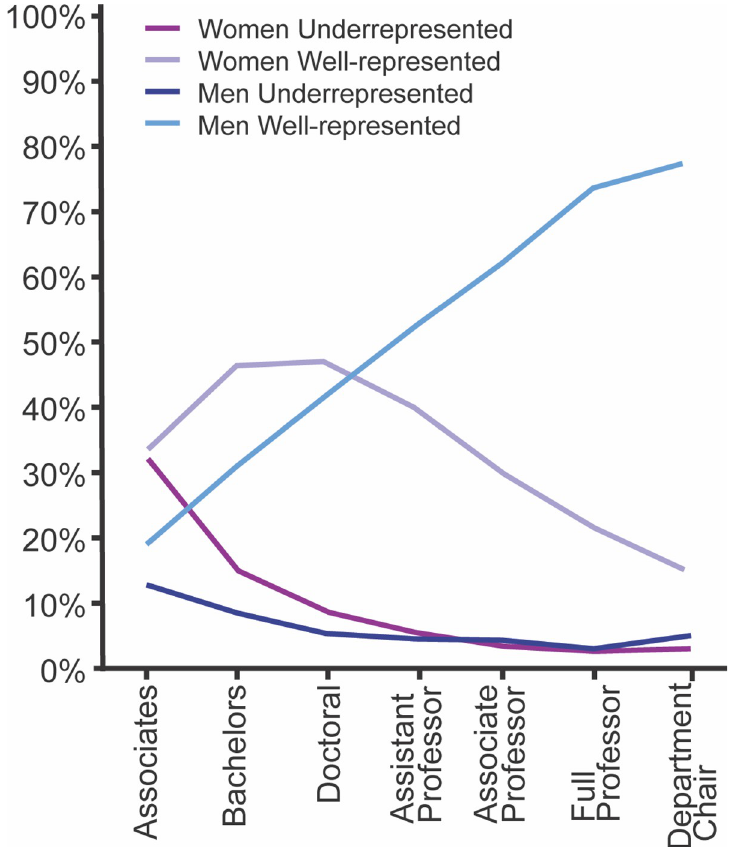
Fig 2. Percent of underrepresented groups compared to well represented groups at different career stages. Underrepresented individuals (as defined in [51]) are lost at multiple academic career stages. Data were compiled from the Fall 2017 and Fall 2018 US Department of Education, National Center for Education Statistics, Integrated Postsecondary Education Data System (IPEDS), and the Association of American Medical Colleges Faculty Roster, 2018. Figure adapted from